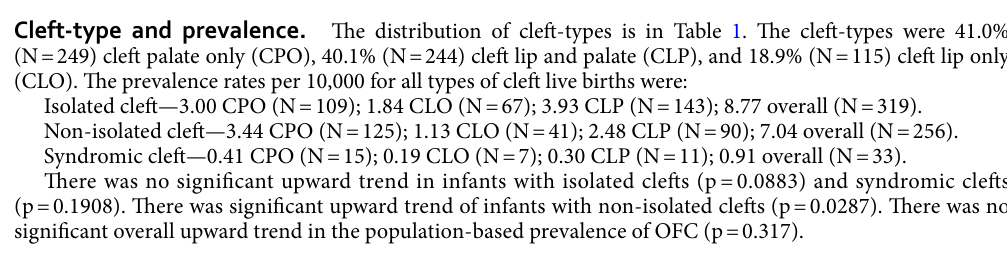
Table 2. Ethnic groups and cleft-types. C Chinese group, M Malay group, I Indian group, O mixed ethnic origins group, NOS not otherwise specified (non-classifiable cleft sub-type in ICD 9 & 10).